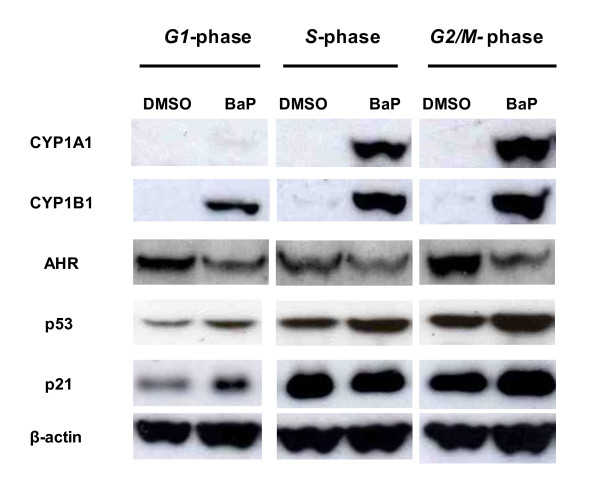
Expression of CYP1A1, CYP1B1, AHR, p53, and p21 protein levels in MCF7 cells in different phases of the cell cycle in response to BaP detected by Western blots. Cells were treated with DMSO (0.3%) or BaP (2.5 μM) for 12 h. 15 μg protein was loaded in each lane. β-actin was used as a loading control.